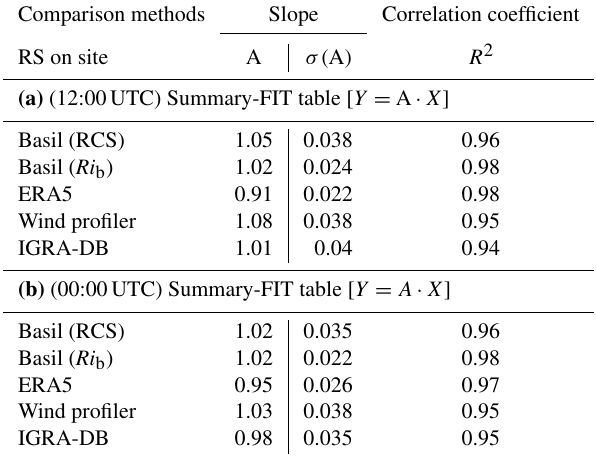
Table 3. Results from the regression analysis, with values of the cor- relation coefficient R 2 and the regression line slope A, with its stan- dard deviation σ (A). Results are reported for both daytime (panel a , 12:00UTC) and night-time (panel b , 00:00UTC)